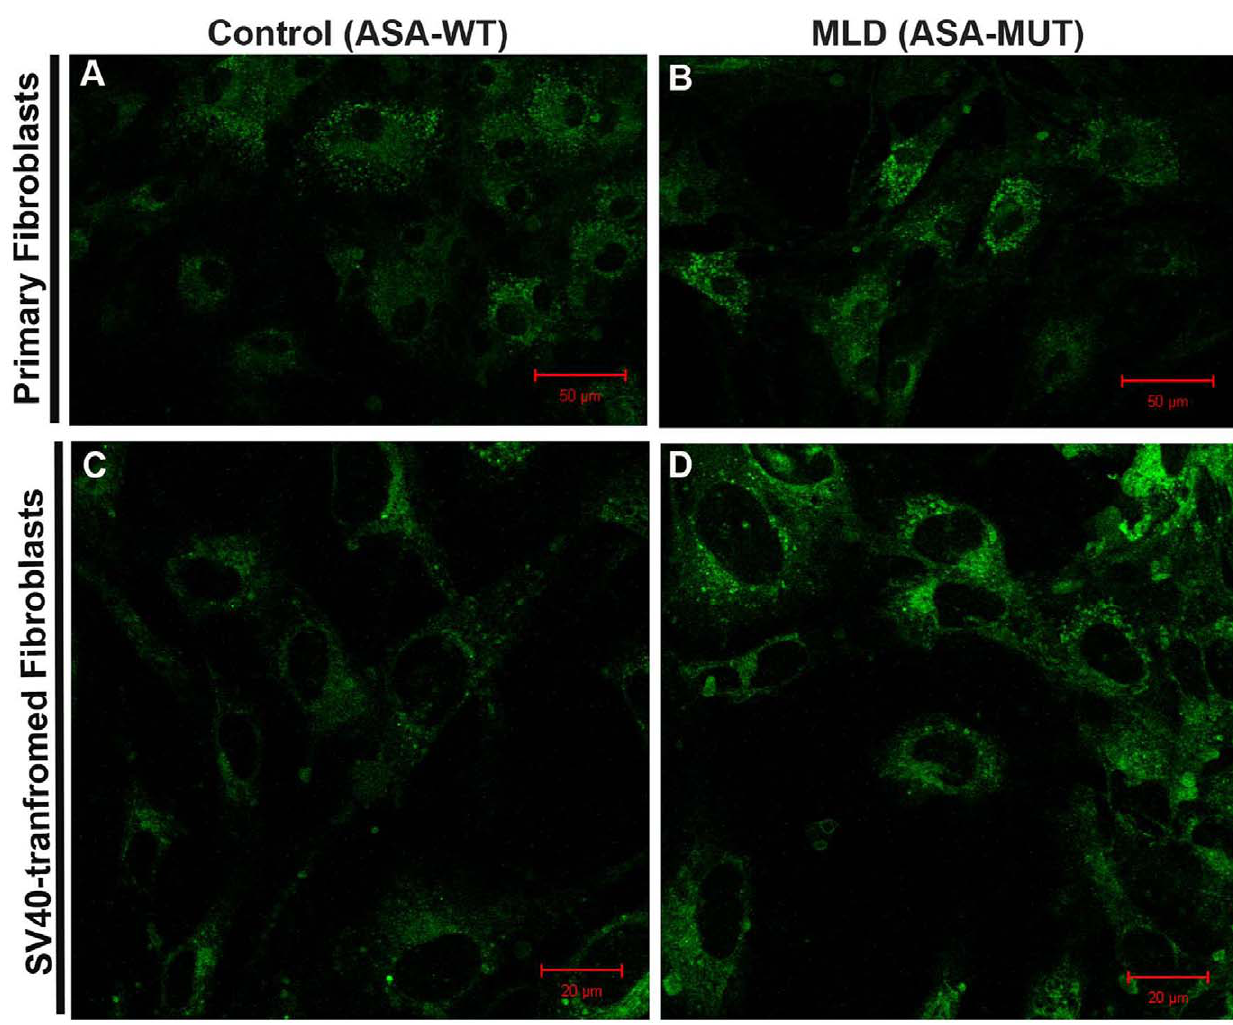
Figure 2. N BD-sulfatide assay in primary and SV40 transformed cultured fibroblasts. Primary and SV40-transformed (SV40t) culture fibroblasts from MLD patient (c.459 + 1G . A/E484L) were exposed over 24hs to 10 nmoles of albumin-conjugated of N BD-sulfatide (see Methods ). The ability of ASA enzymatic activity to degrade the exogenous fluorescent-labeled sulfatide, N BD-sulfatide, can distinguish MLD patient primary fibroblasts (ASA-MUT) ( B ) from controls ( A ) with normal ASA-WT enzymatic activity. SV40t fibroblasts from MLD patient ( D ) also demonstrated elevated accumulation of N BD-sulfatide when compared with SV40t control fibroblasts with normal ASA activity ( C ).